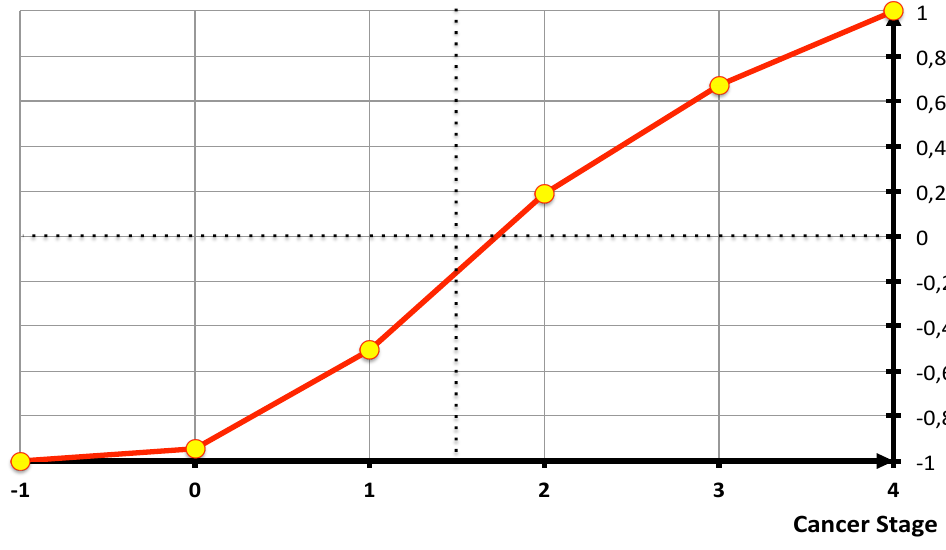
Figure 19. Fuzzy characteristic cancer risk function µ Cancer ( H ( e x ) of PE. - Hospitalization or immobilization after surgery A length of time of one month since surgery, immobilization after a fracture, and hos- pitalization, are all considered risk factors for pulmonary embolism. Since elapsed time is a continuous variable, the characteristic function µ RiskA f terSurgery ( H ( x )) shows that the characteristic function decreases with the time (t is expressed in days) elapsed since the date of fracture or surgery(Figure 20).